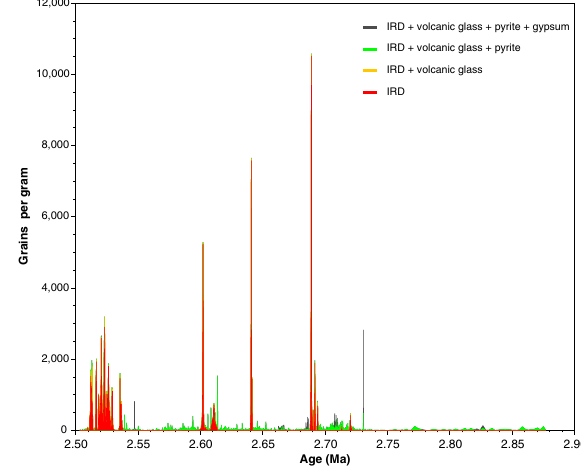
Fig. 8 Stacked plot of IRD, volcanic glass, pyrite, and gypsum. Non- biological coarse grains include many volcanic glasses, pyrite, and gypsum, in addition to